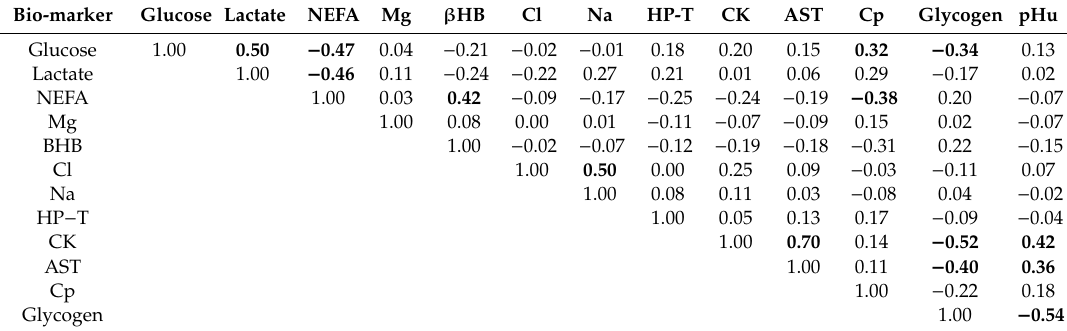
Table 6. Correlation coefficients for blood and muscle metabolites and ultimate pH. Bolded correlations indicate significance at p < 0.05 and r 2 > 0.1.